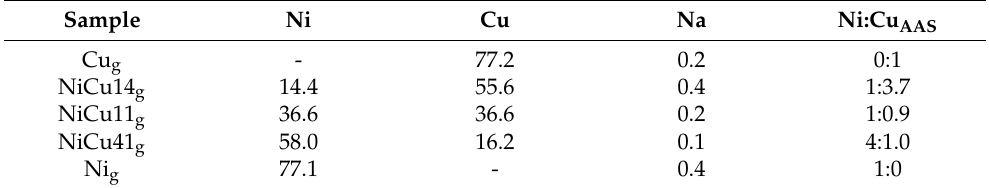
Table 1. Composition of the granular oxide catalyst (prepared from coprecipitated precursors) in wt.% and resulting Ni:Cu molar ratio according to atomic absorption spectroscopy results. Sample